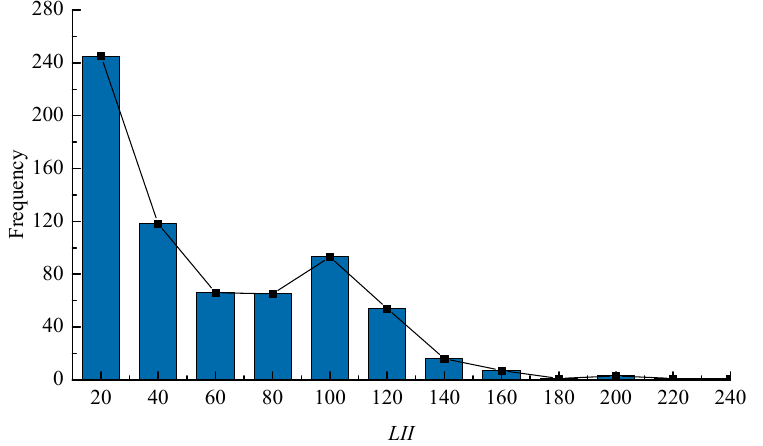
Figure 11. Statistical histogram of roof LII in the study